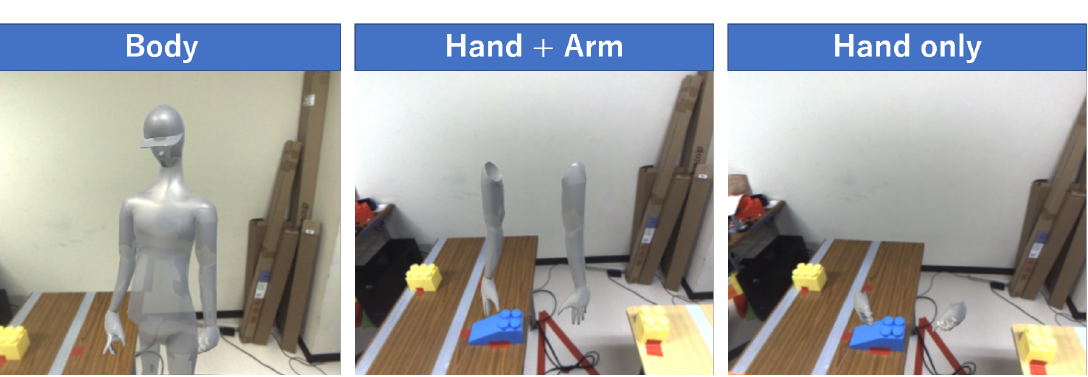
Figure 1. Three types of avatars representing different body representation